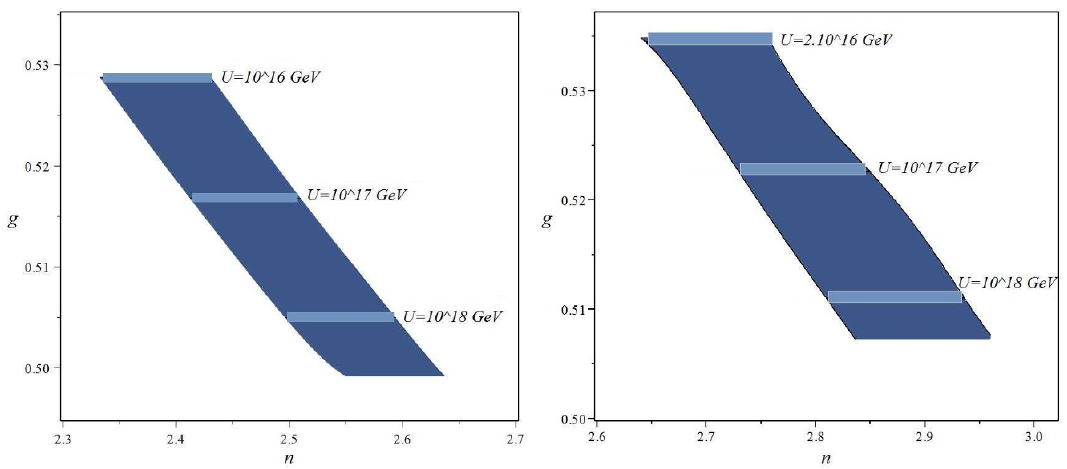
Figure 4 . At any unification scale, there is a small window of choices for unified gauge coupling, g , and the root of neutrino and top quark Yukawa couplings ratio, n , which lead to consistent low energy particle masses with experimental values. Two-loop corrections, left diagram, make the choices a little more